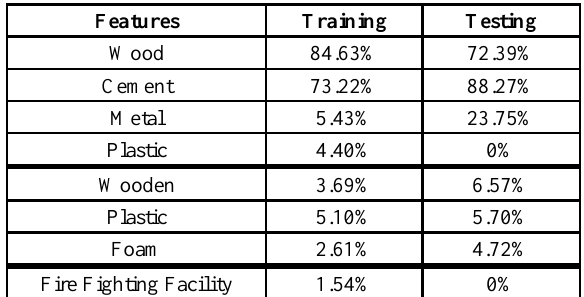
Figure 8. Simulation Results on Test Set in Balutan Tangke (a) and Lanao Danao